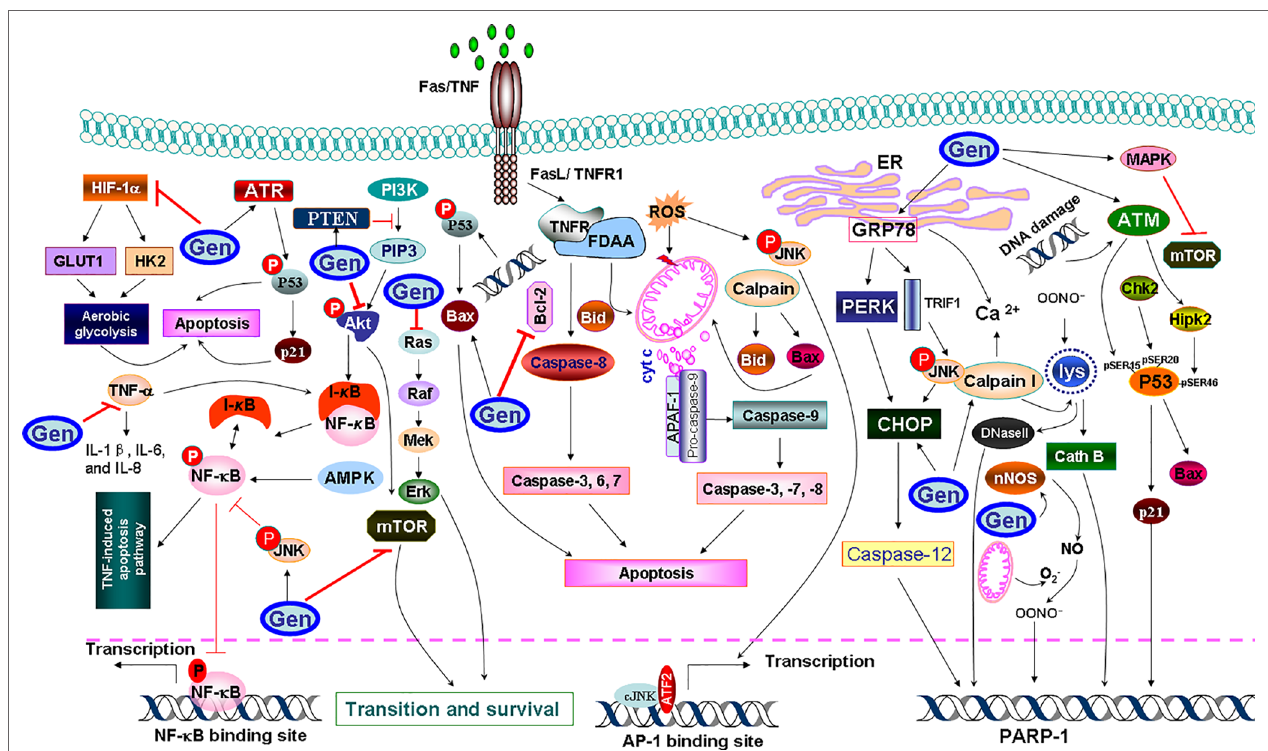
FIGURe 4 | A diagram of mechanistic insight of genistein (Gen) to induce apoptosis in cancer cells. Genistein increases the endoplasmic reticulum (ER) stress- associated protein expressions, such as calpain 1, which cleaves cytosolic Bax and Bid that truncated AIF (tAIF) and cytochrome c (cyt c ) release, along with the activation of the apoptotic protease activator factor 1 (APAF1). Genistein triggers the ER stress through upregulation of glucose-regulated protein 78 (GRP78) expression, which increases the activity of protein kinase R-like ER kinase (PERK), which, in turn activates the transcription factor CCAAT/enhancer-binding protein homologous protein (CHOP) to induce apoptosis. To mediate the extrinsic apoptosis, genistein triggers the combination of a ligand (FasL/TNFR1) and a death receptor (Fas/TNF). Meanwhile, genistein triggers the combination of a ligand (FasL/TNFR1) and a death receptor (Fas/TNF) to mediate the extrinsic pathway. Genistein abolishes tumor necrosis factor-α (TNF-α)-induced nuclear factor-κB (NF-κB) translocation as well as phosphorylation of IκB kinase-α/β and IκBα. Genistein also enhances the phosphorylation and activation of ATM/ATR-p53-p21 signaling pathway. Calpain I also permeabilizes lysosomal (lys) membranes, resulting in release of cathepsin B (Cath B) and DNase II. Genistein downregulates hypoxia-inducible factor-1α (HIF-1α), therefore inactivating glucose transporter 1 (GLUT1) or/and hexokinase 2 (HK2), which in turn suppresses aerobic glycolysis and mediates